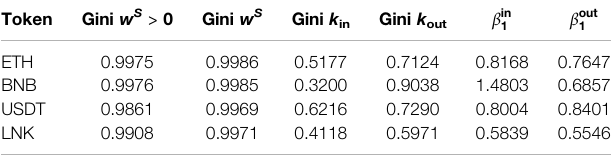
TABLE 6 | Gini Coef fi cients for wealth ( w S ), in-degree ( k in ), and out-degree ( k out ). First, w S fi ltersoutnonzerovalue(sincethegraphiscumulative,oldaddresses appearing in the network are accounted but might no longer hold tokens). For comparison, the second wealth includes instead all the addresses in the network.